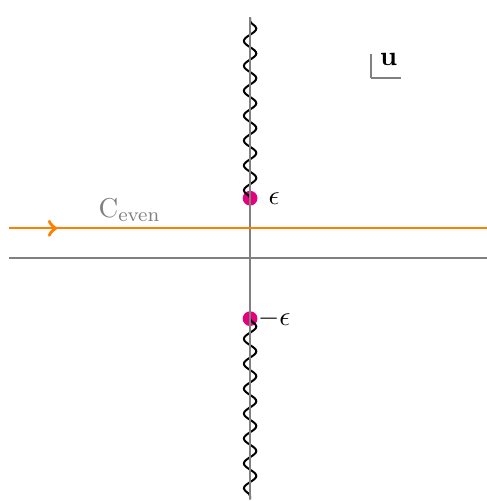
Figure 3. Contour C even in the u -plane for even AdS d